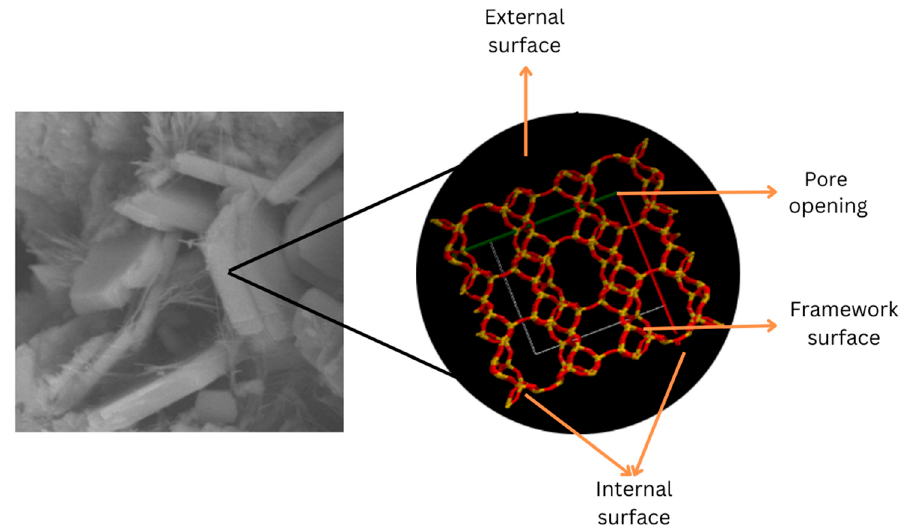
Figure 2. An HEU zeolite crystal, channel structures and external surface (exemplified by the (010) surface). The channels are drawn superimposed onto the crystals for illustration purposes and are not drawn according to scale. The external surface consists of pore openings and the framework surface.